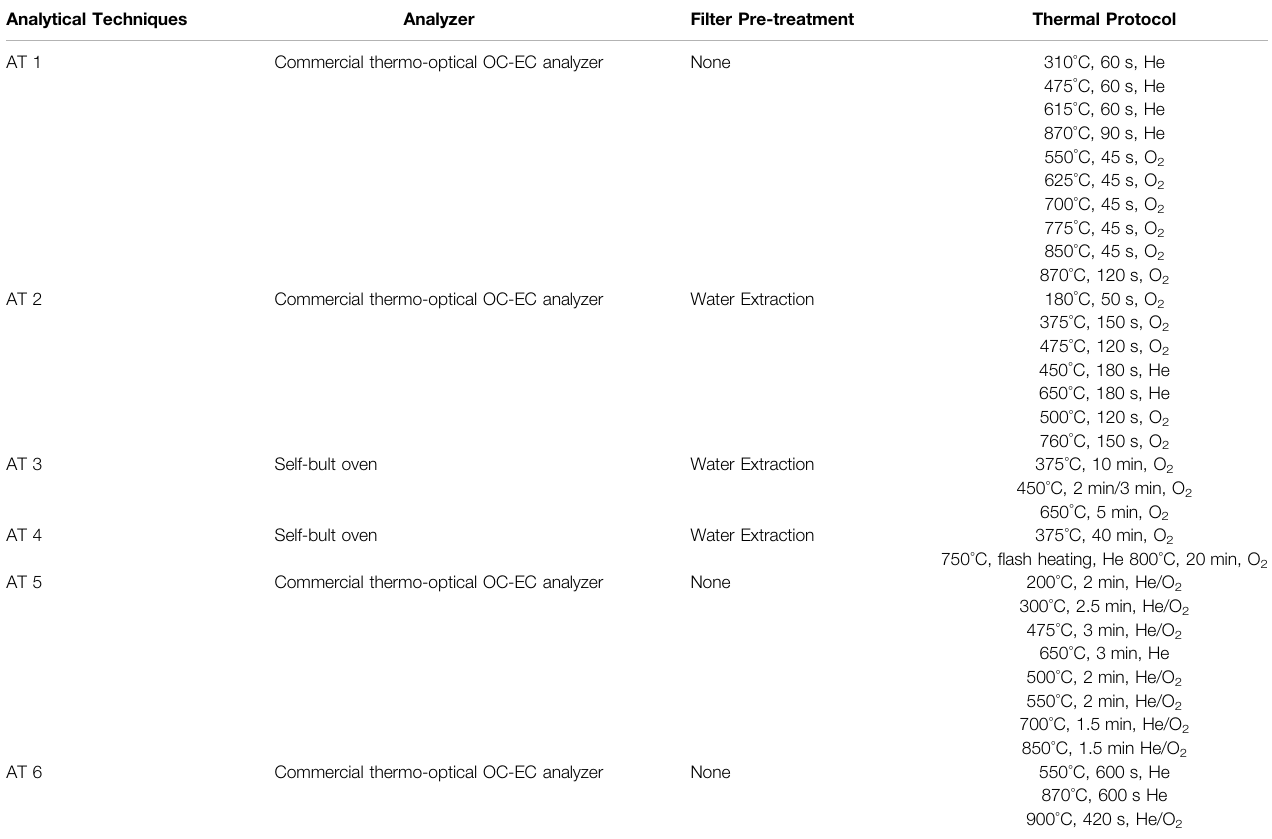
TABLE1| Alistofthereviewedandcurrentlyusedanalyticaltechniques(ATs)fortheisolationofBCfroma fi ltermatrixforradiocarbonanalysis.AT1(Gustafssonetal.,2009; Andersson et al., 2015), AT 2 (Zhang et al., 2012), AT 3 (Dusek et al., 2014; Zenker et al., 2017), AT 4 (Bernardoni et al., 2013),AT 5 (Liu et al., 2017),AT 6 (Huang et al.,